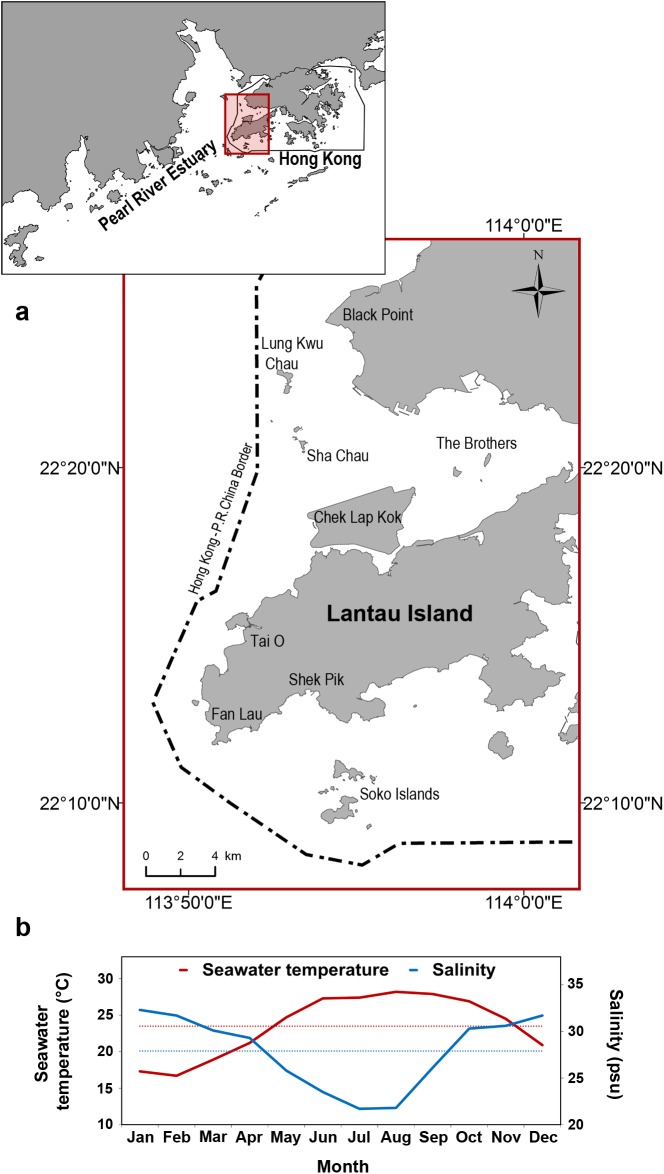
(a) The study area in western Hong Kong waters, at the eastern reaches of Pearl River Estuary, southeast China. Photo-ID surveys covered the entire region of Hong Kong territorial waters known to be inhabited by Indo-Pacific humpback dolphins [43], including west coast of Lantau Island to the extent of Sha Chau-Lung Kwu Chau Marine Park and Black Point in the north, The Brothers islands in the north-east, Shek Pik peninsula and Soko Islands in the south/south-east. The dolphins are rarely seen further east in Hong Kong waters [43,48] The thick broken line represents the administrative border separating Hong Kong Special Administrative Region (Hong Kong S.A.R.) and People's Republic of China, which demarcates the western boundary of the study area. The map was generated by S.C.Y. Chan using software ArcGIS (Version 10.2, http://www.esri.com/software/arcgis). (b) The mean monthly (solid lines) and annual mean (dotted horizontal lines) seawater temperature and salinity, averaged across measurements at the surface, mid-water column and at the bottom, in western Hong Kong waters during 2010–2013. (Data source: Environmental Protection Department HKSAR, 2015; http://epic.epd.gov.hk/EPICRIVER/marine/).